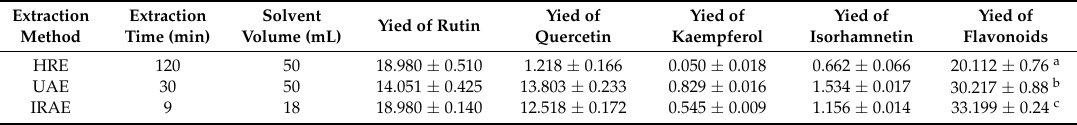
Table 5. Comparison of extraction yield of four flavonoids among different methods (mg/g, n = 3). Extraction Extraction Solvent Method Time (min) Volume (mL)